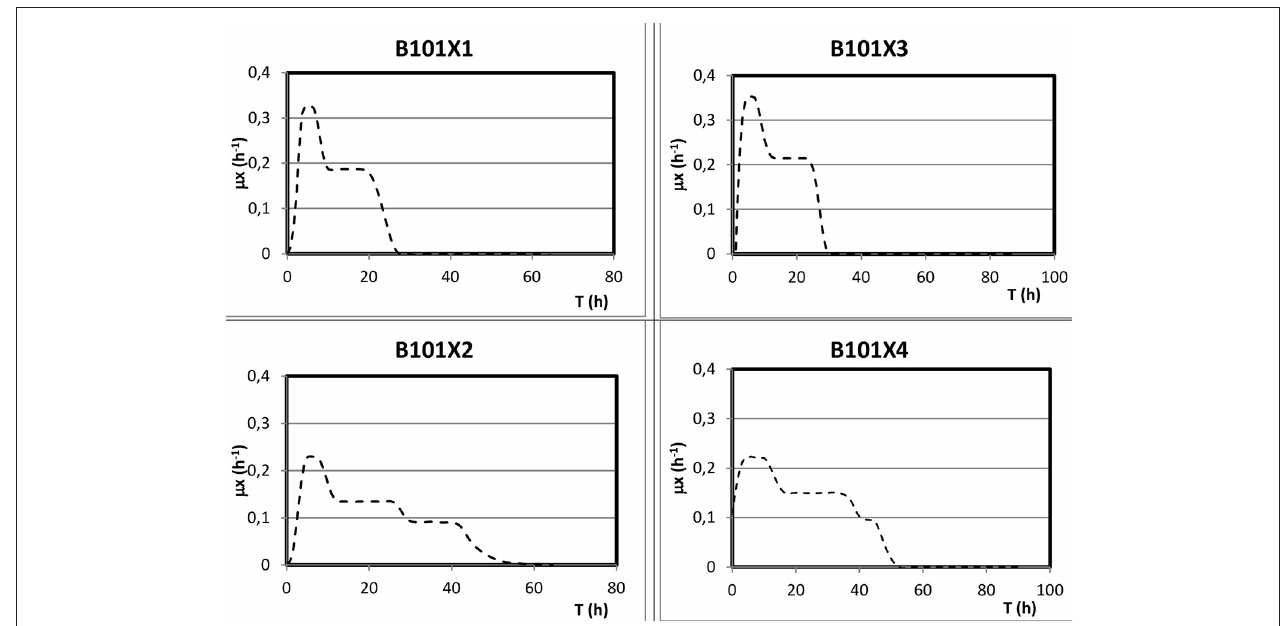
FIGURE 6 | Representation of the obtained µ in different culture media.